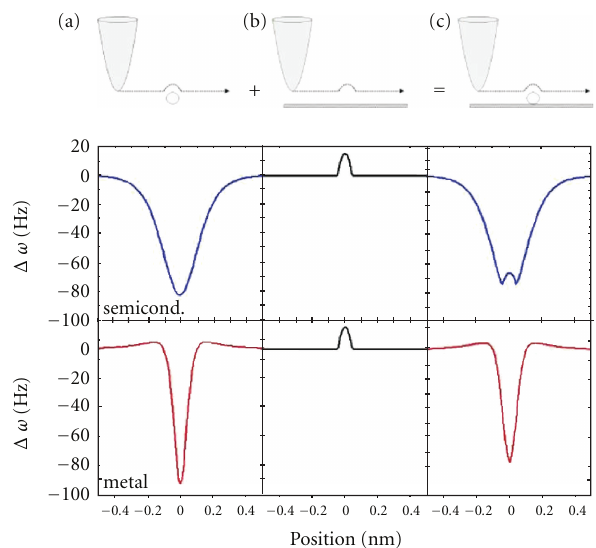
Figure 7: The EFM profiles for semiconducting and metallic SWNTs. In column (a), the e ff ect of the EFM tip crossing a semiconductor (blue) and a metallic (red) SWNTs on Δ ω is shown. The lineshapes are di ff erent due to the di ff erences in dielectric response. In column (b) the e ff ect of the EFM tip retracting from the substrate on Δ ω is shown. Here the e ff ect is the same for both semiconductors and metals. In column (c) the two e ff ects are combined. The equations in [57] were used to build these plots